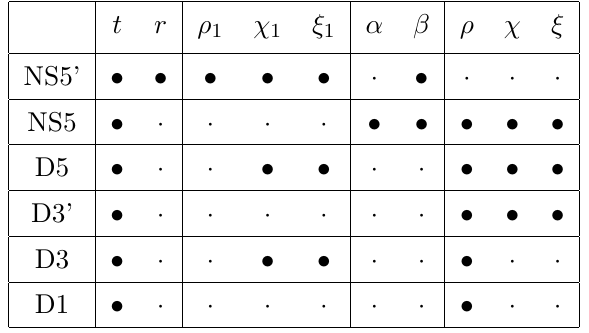
Table 1 . Overview of the brane content of the Type IIB supergravity solution in eqs. (3.1){(3.2), with the directions along which the branes are